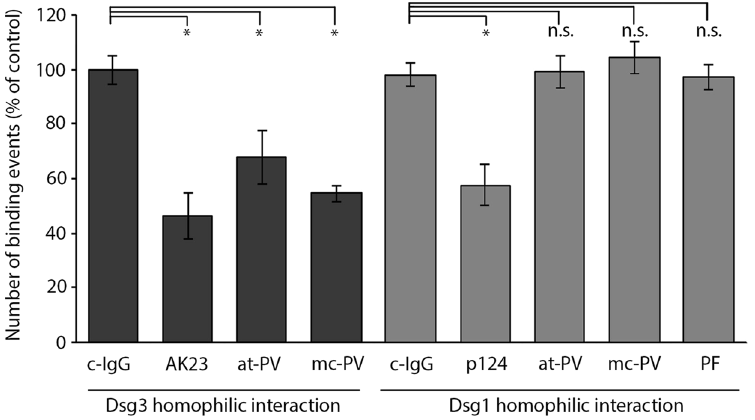
Figure 3. Inhibition of Dsg3 but not Dsg1 homophilic interactions by pemphigus autoantibodies. Cell free atomic force microscopy measurements on a coated mica sheet with an AFM tip functionalized with either recombinant Dsg1-Fc or Dsg3-Fc respectively. A grid with 10 × 10 points (2.5 × 2.5 μ m) was measured 5 times followed by incubation with IgG-fractions, AK23 or the mouse monoclonal Dsg1 antibody p124. The identical area was scanned again and normalized to the respective measurement before incubation (n = 3–5, * p ≤ 0.05 vs.